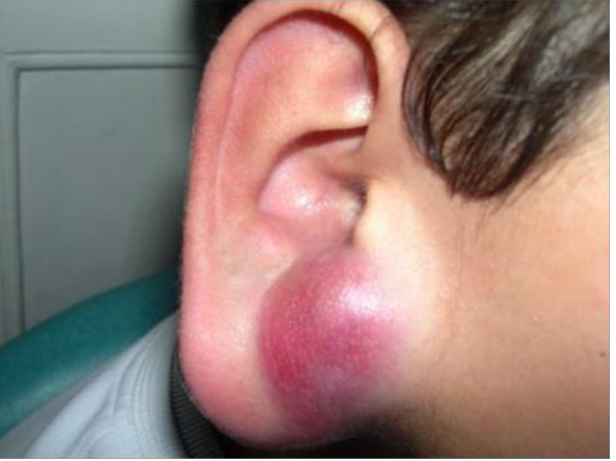
Figure 12. Rhabdomyosarcoma of the ear in a young boy: solitary erythematous nodule. Microscopically, primarily cutaneous ARMS is similar to ARMS in other locations; it is composed of nests of undifferentiated small round cells with a high N/C ratio and a variable proportion of tumor cells with a moderate eosinophilic cytoplasm. True differen- tiated rhabdomyoblasts are rare. In the center of the nests, the cells show discohesion with a tendency to disaggregate, leading to the alveolar pattern. Multinucleated tumor cells are a rather common finding. Mitoses can be sparse or more prominent and necrosis is possi- ble [127,128,132]. Tumor cells express skeletal muscle markers: desmin, myogenin (Myf4), and/or